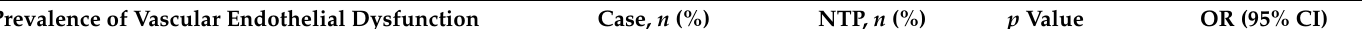
Table 5. Impact of a history of pregnancy-related complications (GH, PE, FGR) with respect to the severity of the disease and delivery date on prevalence of vascular endothelial dysfunction_ overview (logistic regression